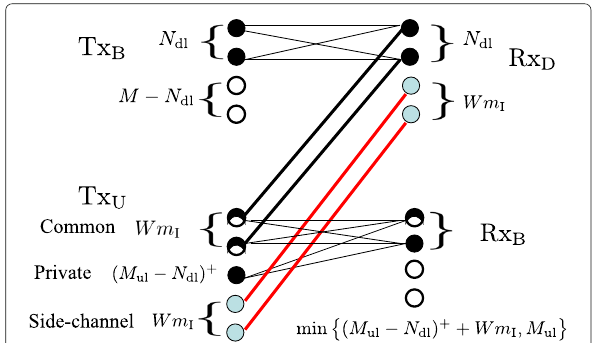
Fig. 6 The DoF-optimal scheme of two-user side-channel-assisted MIMO full-duplex network when M ul ≥ N dl